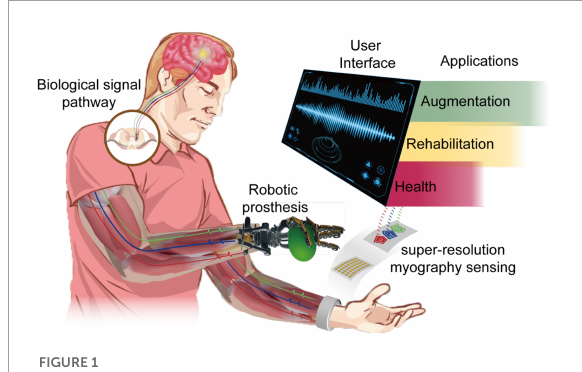
FIGURE1 Schematic illustration of wearable super-resolution myography and its